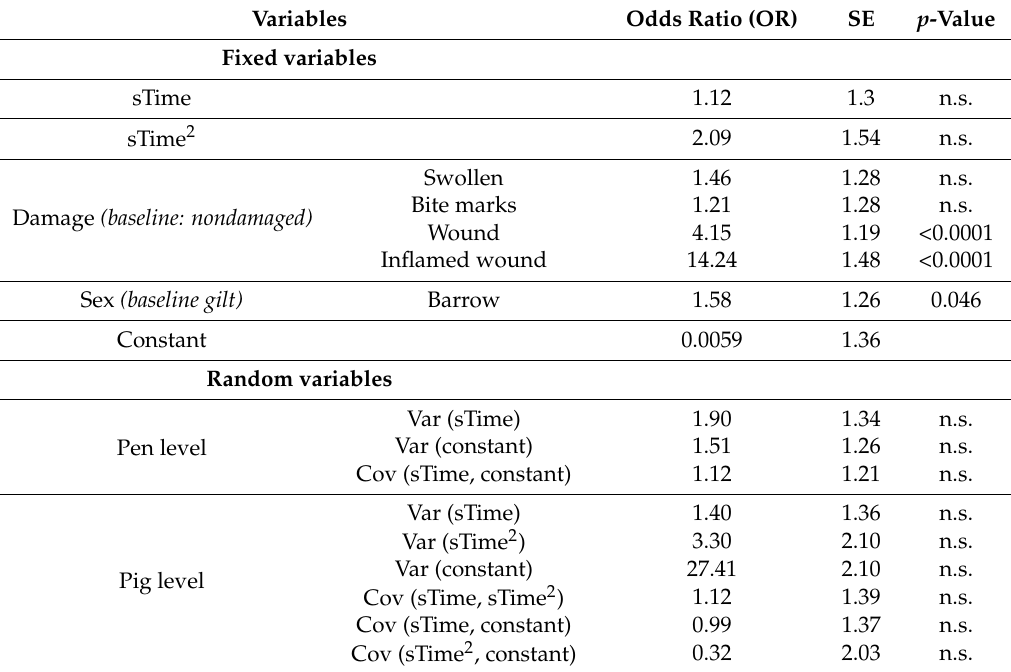
Table 3. Binomial multivariate regression model of hanging tails for 459 pigs in 42 pens over 14 weeks (one observation per week) (n =